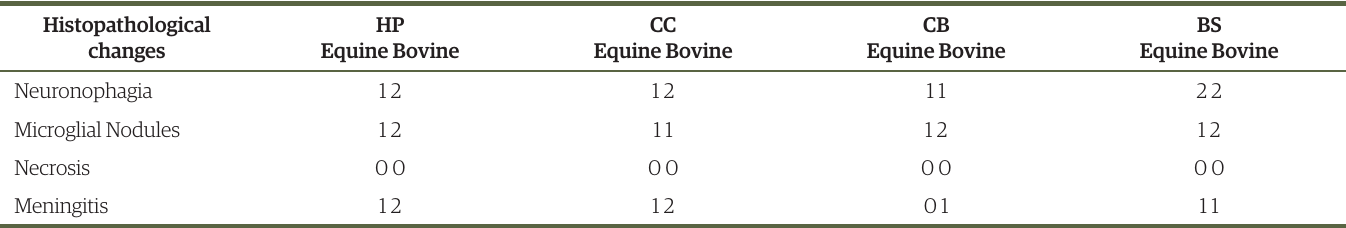
Table 2. Distribution and degree of histopathological changes in different regions of the CNS of equines and bovines naturally infected with the rabies virus. Histopathological